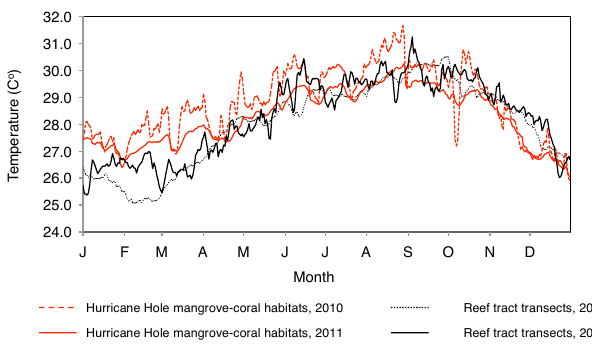
Figure 8. Temperature trends from mangrove–coral and reef tract habitats. Hurricane Hole temperature data were averaged from 18 data loggers distributed throughout Hurricane Hole bays (Table 2). Temperature measurements were recorded every 2h and daily av- erages were generated from all sites in Hurricane Hole and from 6 reef sites around St. John. Data are available at http://doi.pangaea.